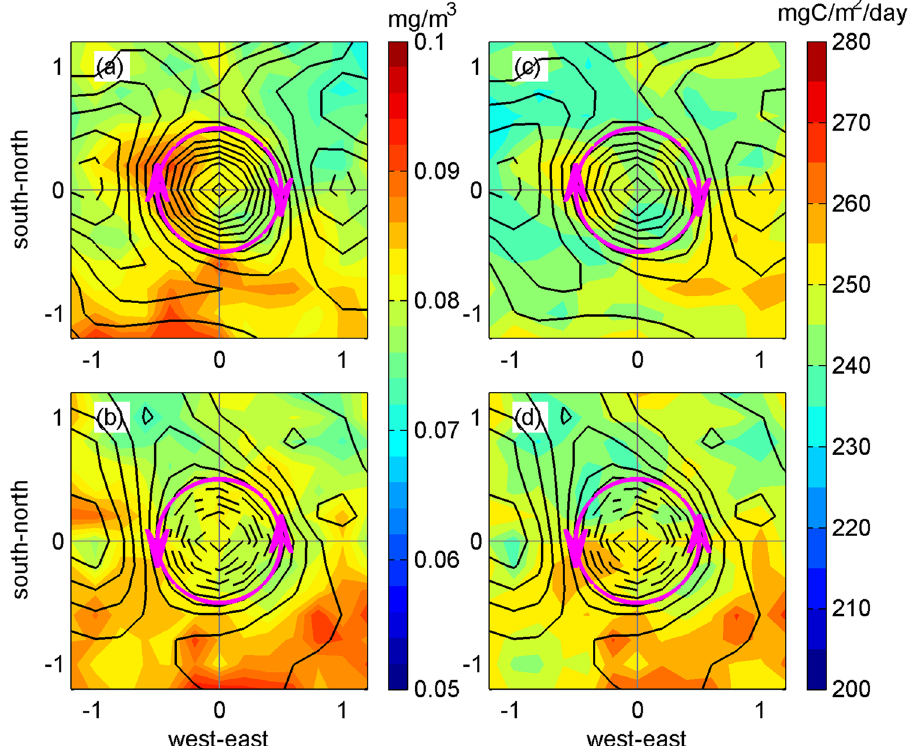
Figure 4. Composite of Chl (left panels) and NPP (right panels) for anticyclonic ( a and c ) and cyclonic ( b and d ) eddies within 135–165°E and 15–28°N in July 2003. The x- and y-axes are the normalized distance from eddy cores with grid resolution of 0.2. All values are significantly different from means (0.06 mg/m 3 for Chl and 203 mg C/m 2 /day for NPP) at the 95% confidence level based on t